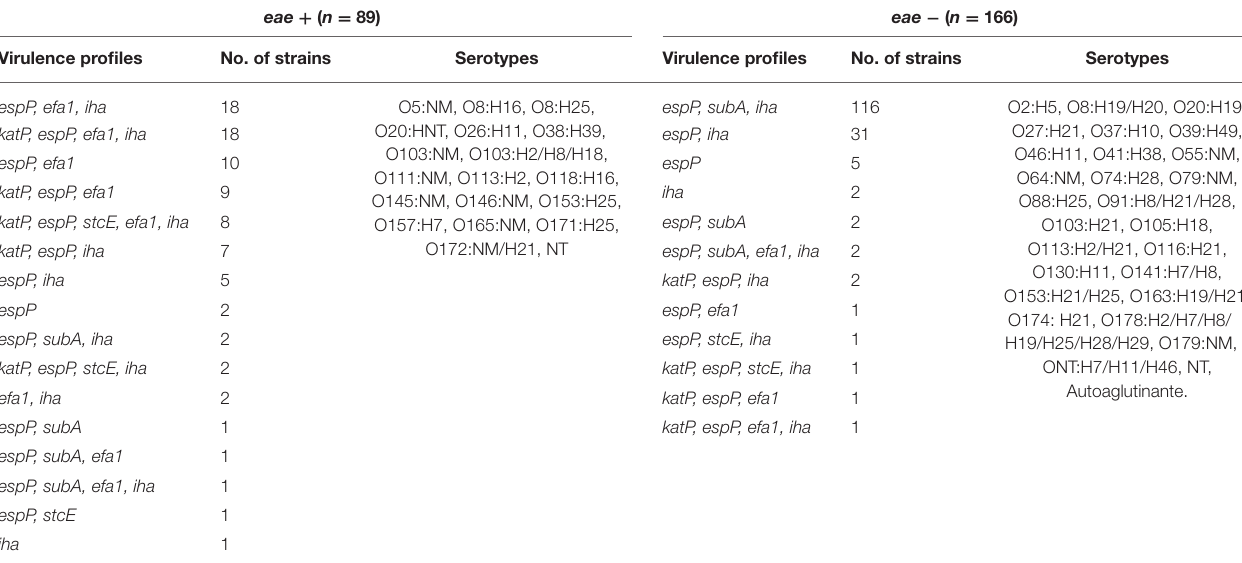
TABLE 3 | Virulence profiles in STEC strain according to presence or absence of eae . eae + ( n = 89) eae − ( n = 166) Virulence profiles No. of strains Serotypes Virulence profiles No. of strains